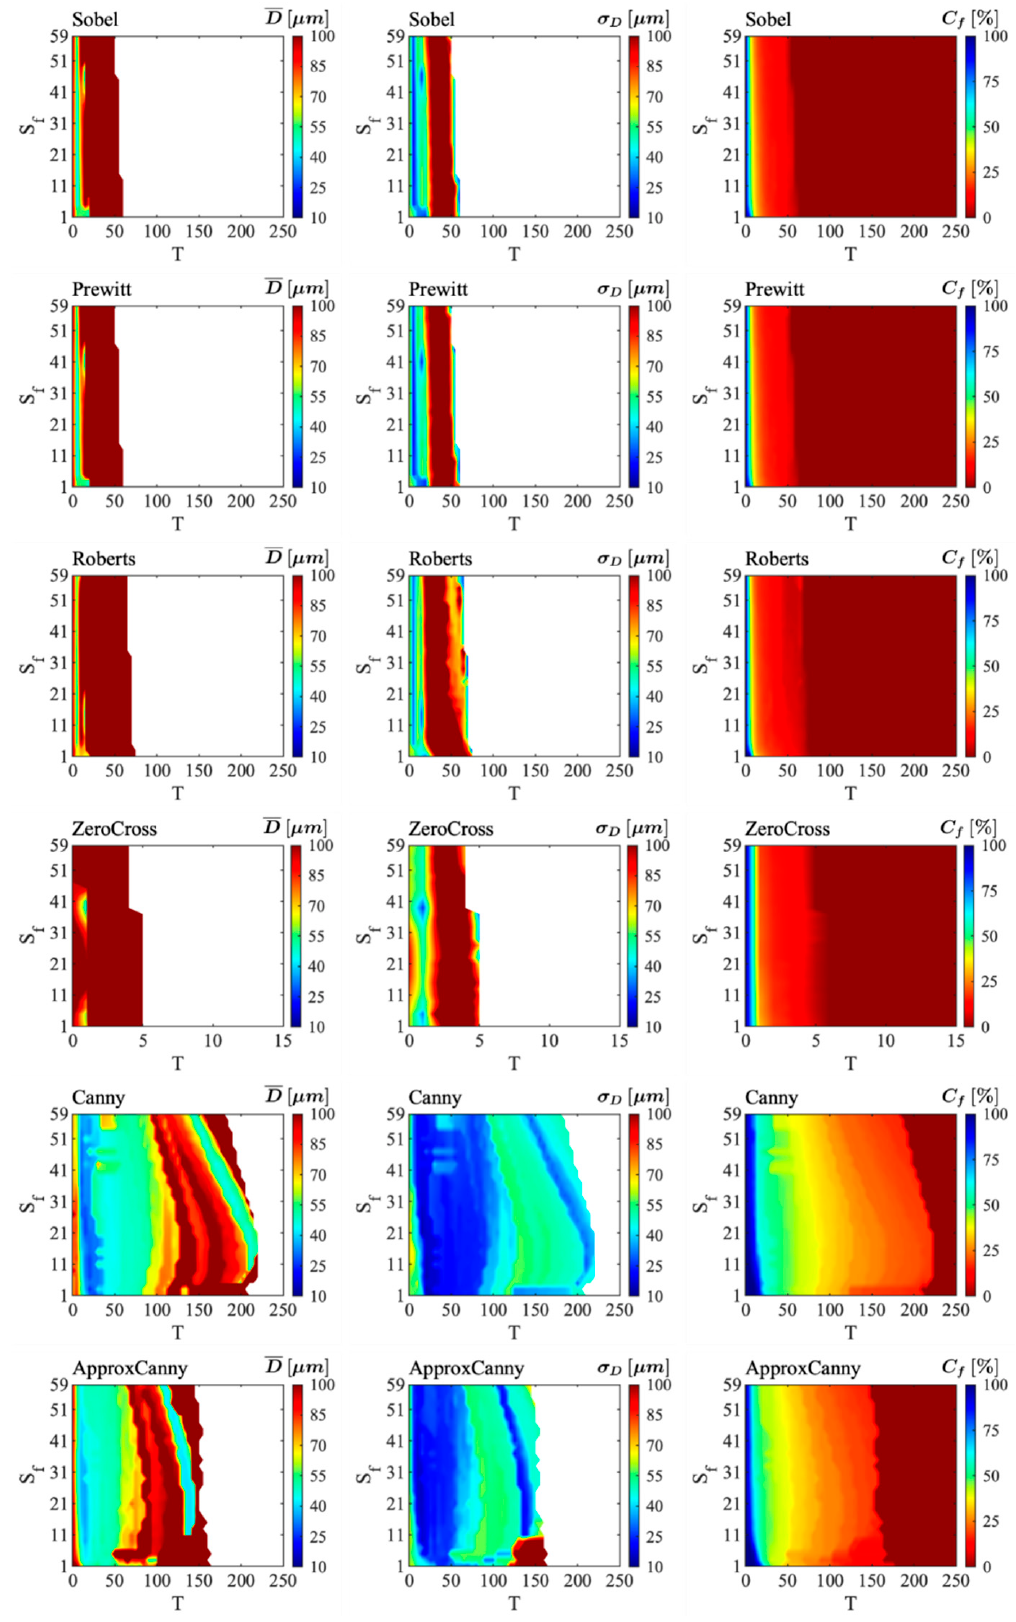
Figure 18. MQI results as a function of 𝑆 (cid:3033) and 𝑇 for every 𝑀 calculated for 𝑆04 .